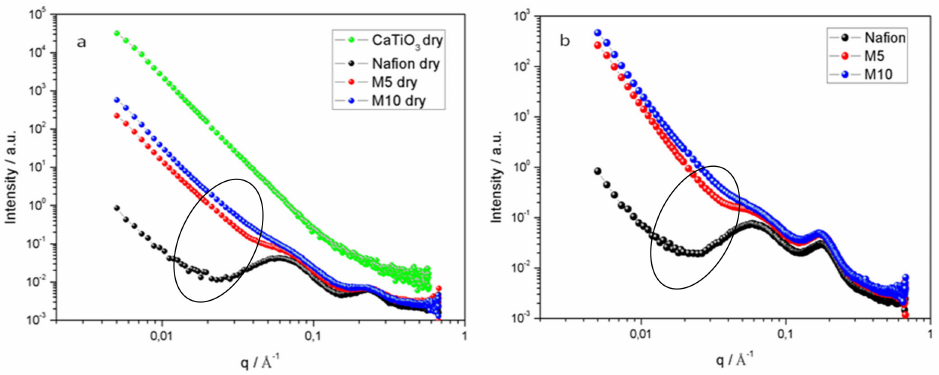
Figure 1. SAXS and WAXS patterns of all the Nafion membranes here investigated under dry ( a ) and humidified ( b ) conditions. The pattern of CTO dry powder is also reported for comparison purpose.